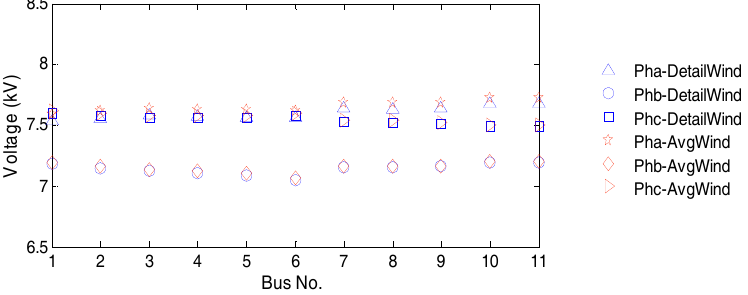
Figure 17. Comparison of DFIG models in steady state operating phase RMS voltages for islanded operation after switching the capacitors.